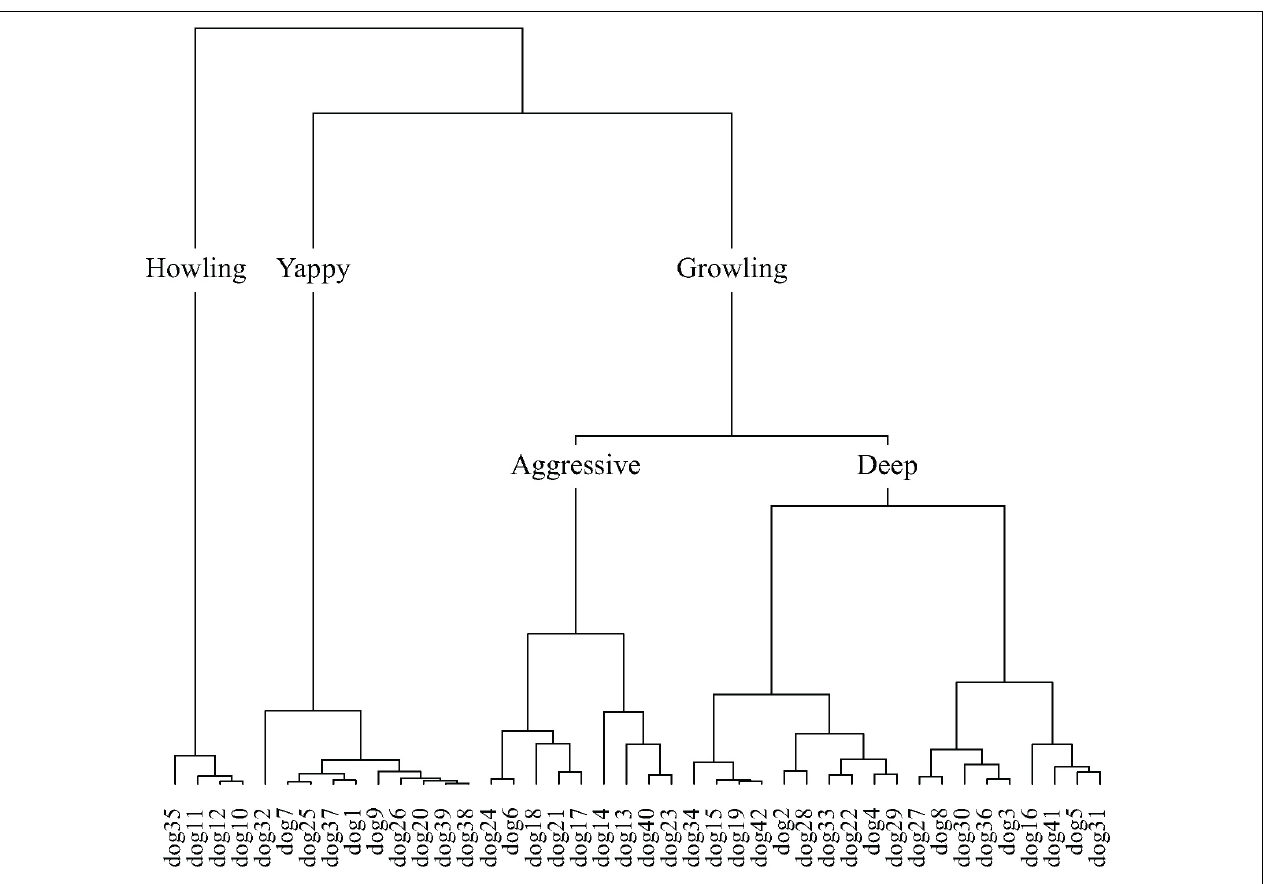
FIGURE 9 | The dog taxonomy generated by hierarchical cluster analysis of the principal dimensions resulting from correspondence